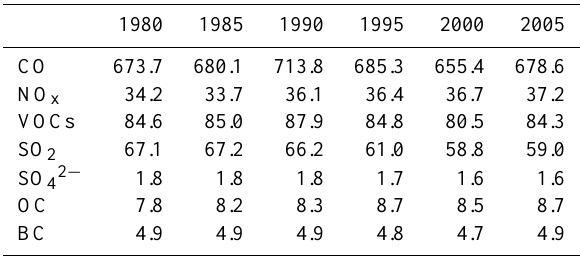
Global anthropogenic emissions of CO [Tgyr − 1